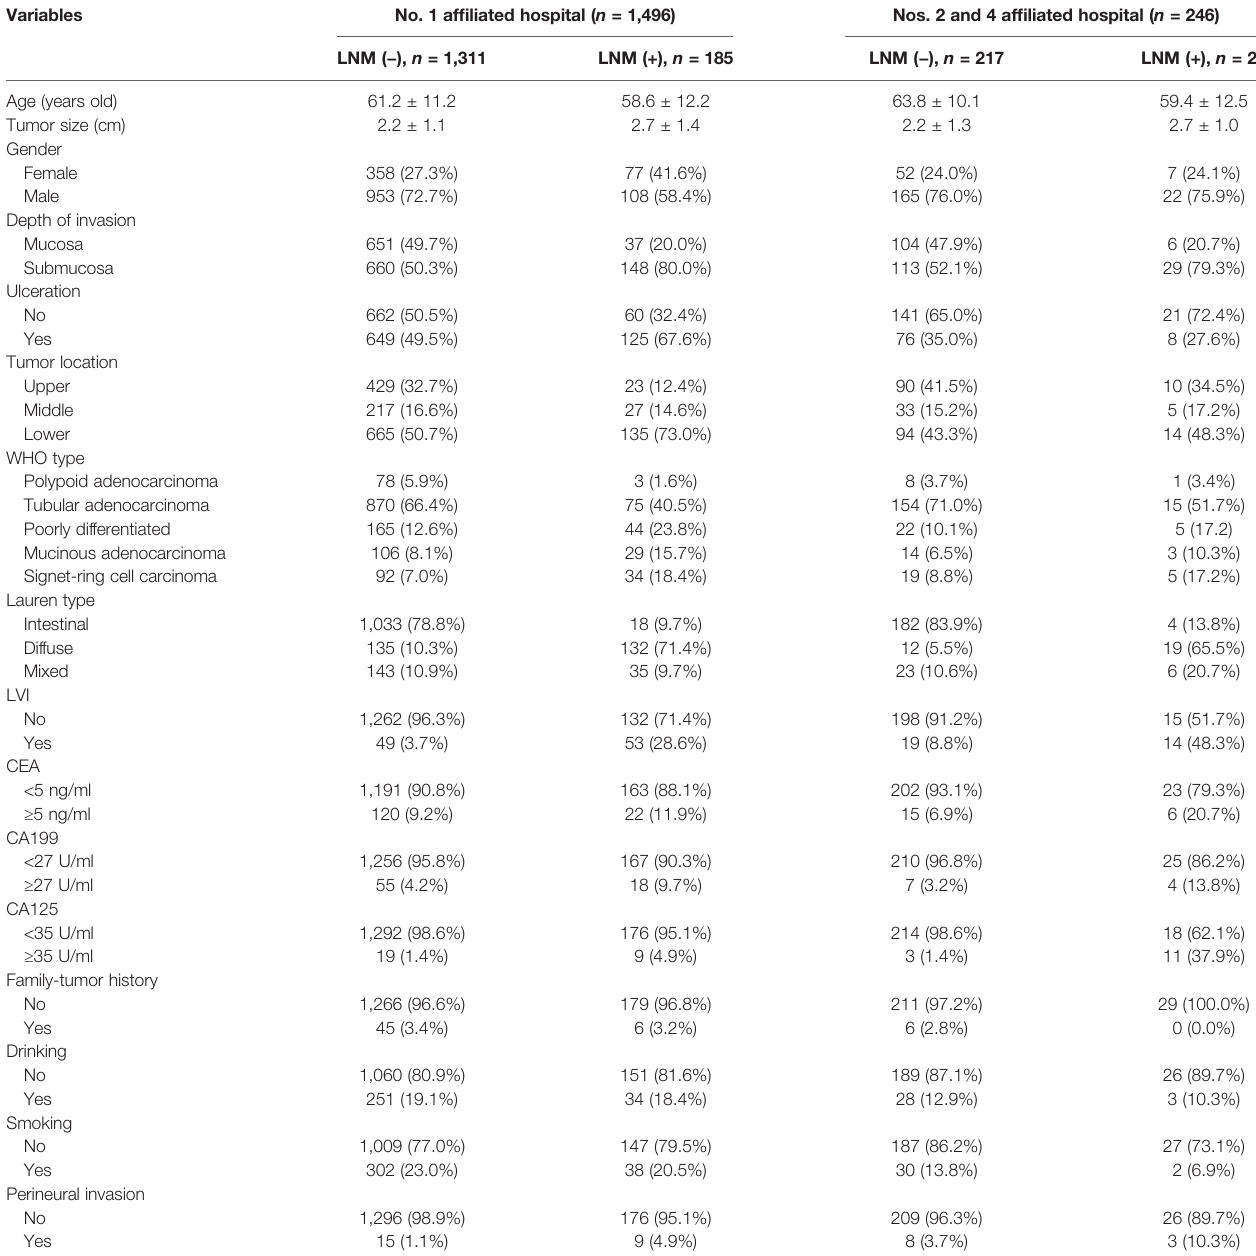
TABLE 1 | Characteristic of 1,742 patients with EGC from three clinical centers.